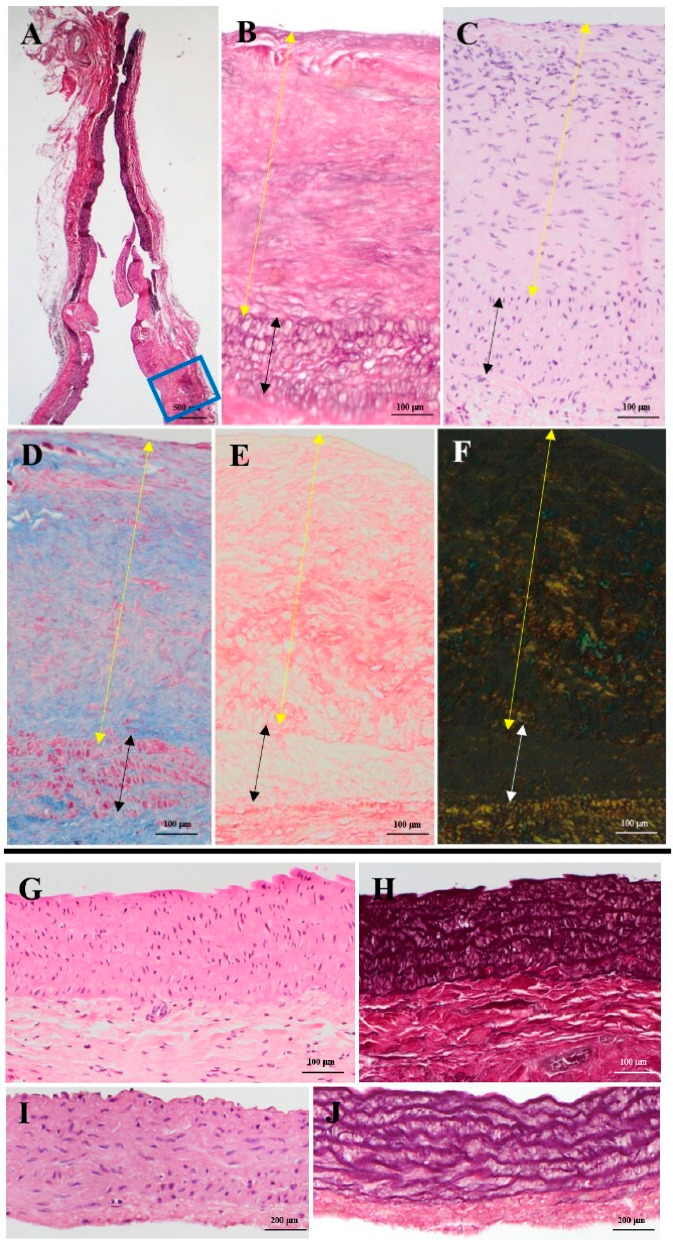
Figure 6. ( A ) Same section shown in Figure 5D. ( B – E ) Detail of the PAG wall highlighted by the blue box in ( A ). The black and white arrows indicate the tunica media, while the yellow ones indicate